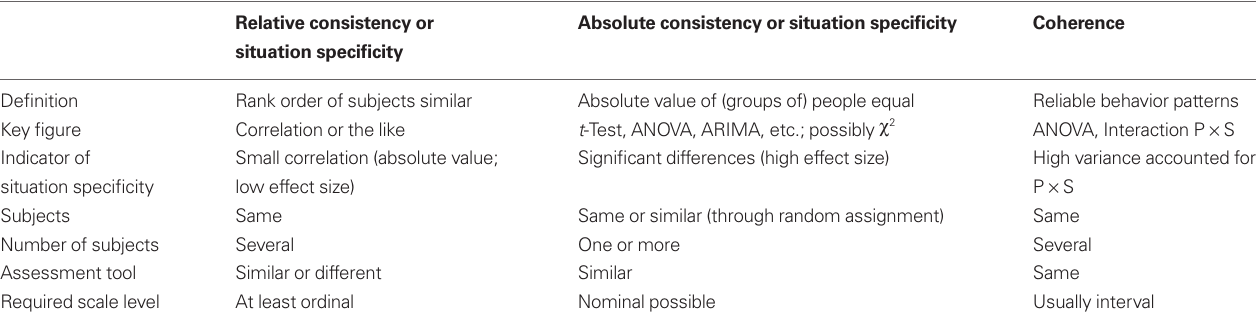
Table 1 | Types of consistency (with additions from Patry, 2000, p.16; translated from